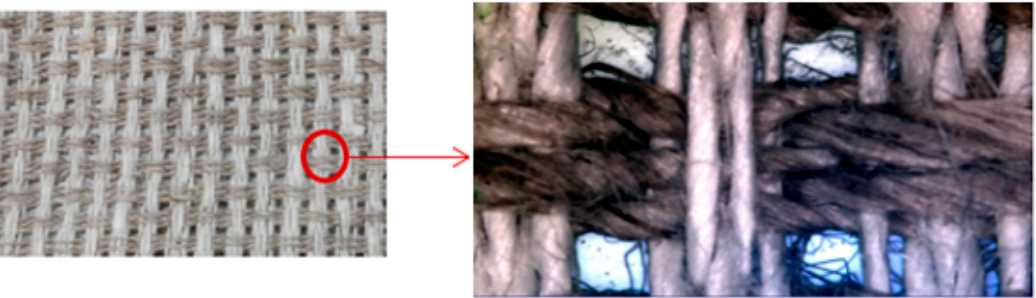
Figure 1. Detailed observation of the fabric architecture.